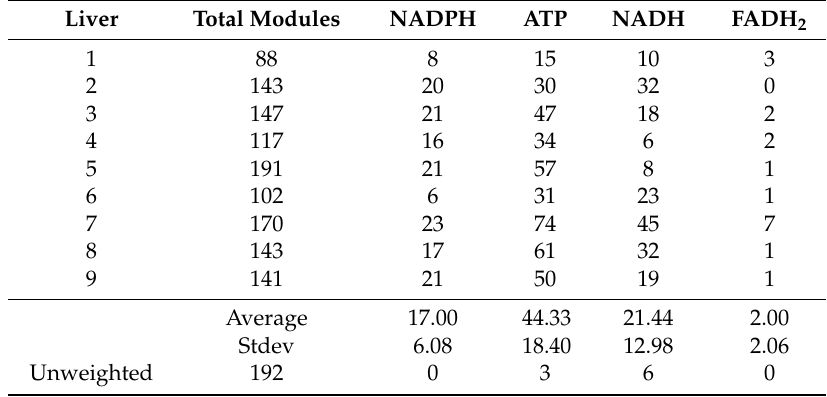
Table 5. For each liver, the number of modules that satisfy the baseline criteria based on edge-weighted network partitioning is listed along with the number of modules that contain at each of the four specified cofactors (ATP, NADH, NADPH,